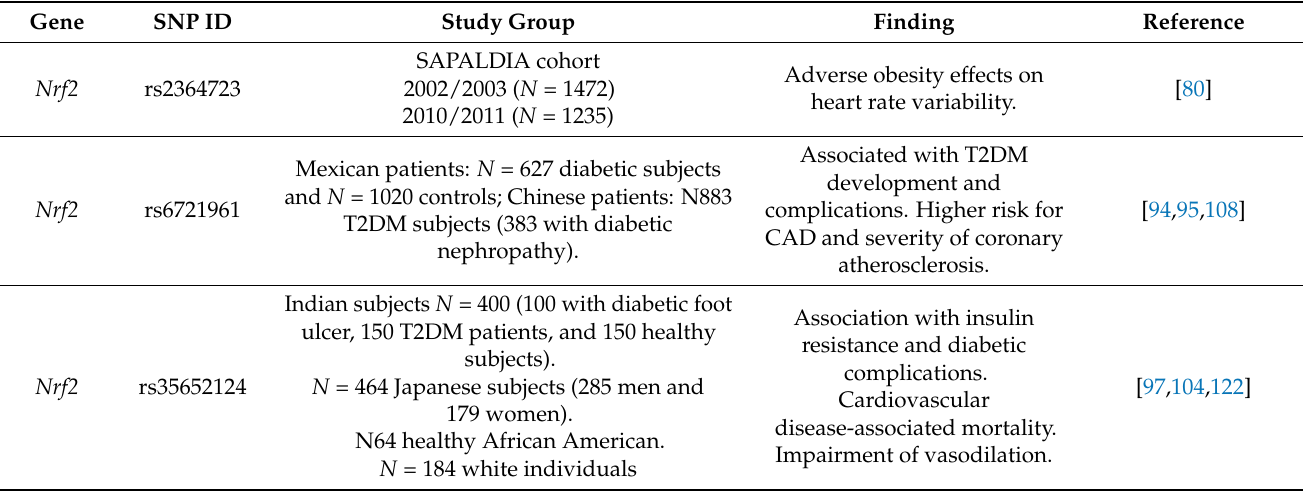
Table 1. Association of SNPs of Nrf2 and related genes with cardiometabolic